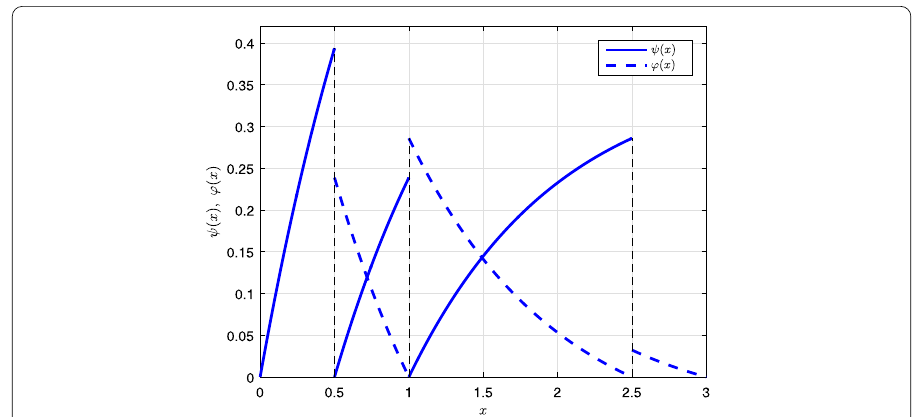
Figure 1 Local Green functions Graphs of the local Green functions ψ 0 , ψ 1 , and ψ 2 (with solid lines) and ϕ 1 , ϕ 2 , and ϕ 3 (with dotted lines) when κ ( x ) = e x and n =